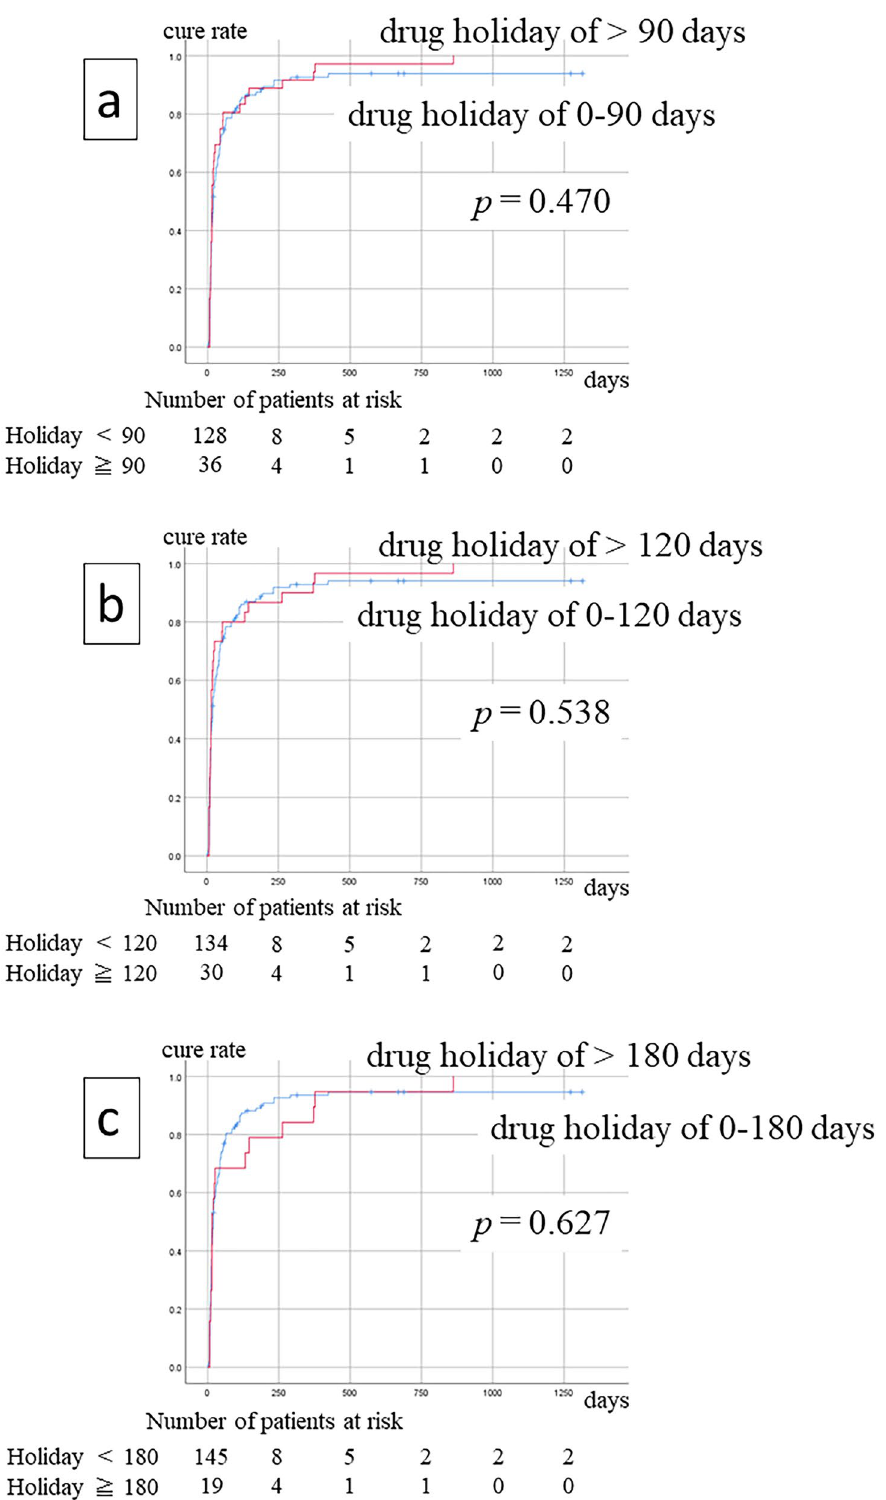
Figure 2. Treatment outcomes did not improve after 90 ( a ), 120 ( b ), or 180 ( c ) days of drug